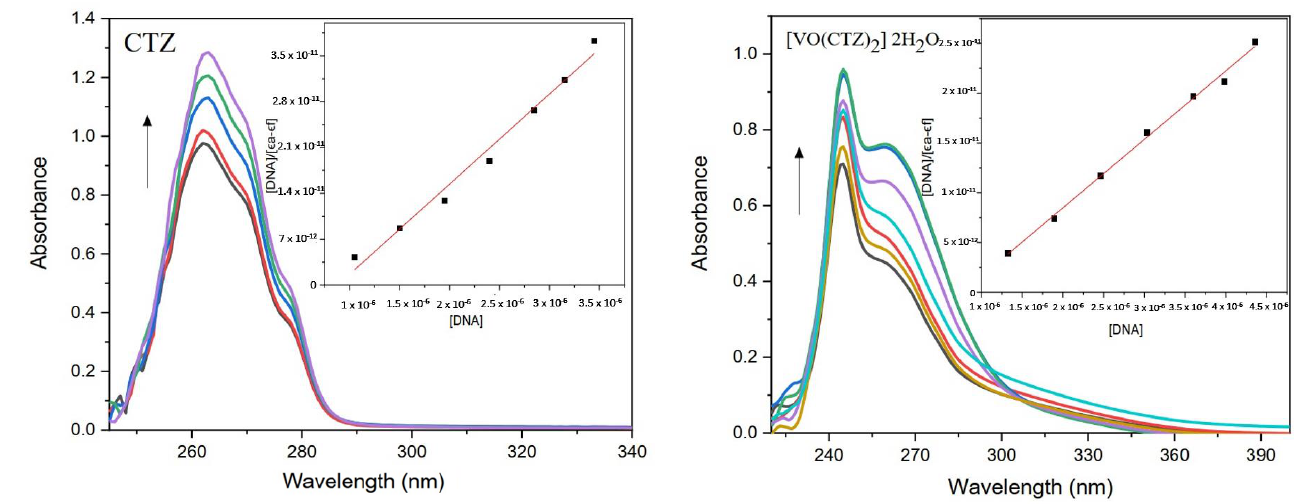
Figure 6. Absorption spectra of CTZ and its metal complex in the presence of increasing DNA concentration (arrow indicates changes with increasing DNA concentration).